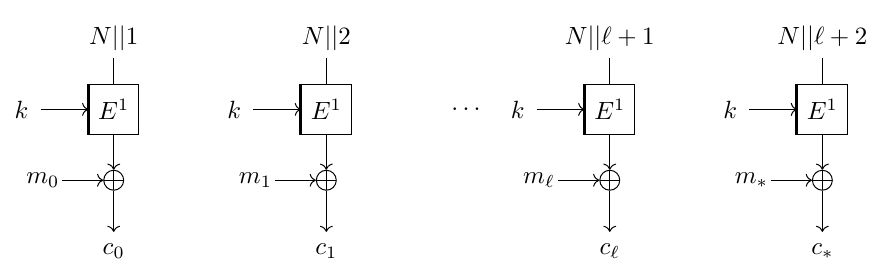
Figure 6: Counter Mode (CTR) encryption ( 𝐸 𝑖 denotes a tweakable block cipher with Tweak 𝑖 . A thick line represents the input of the key.